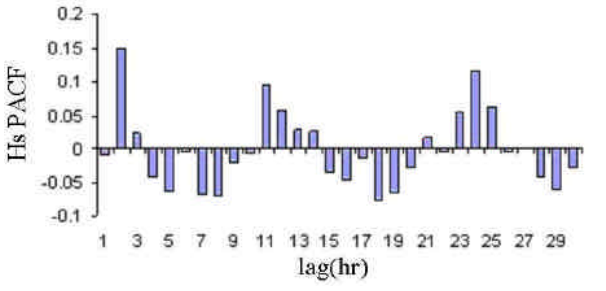
Figure13. Significant wave height partial auto correlation with 1hr time lag Fig. 13. Significant wave height partial autocorrelation with 1-h